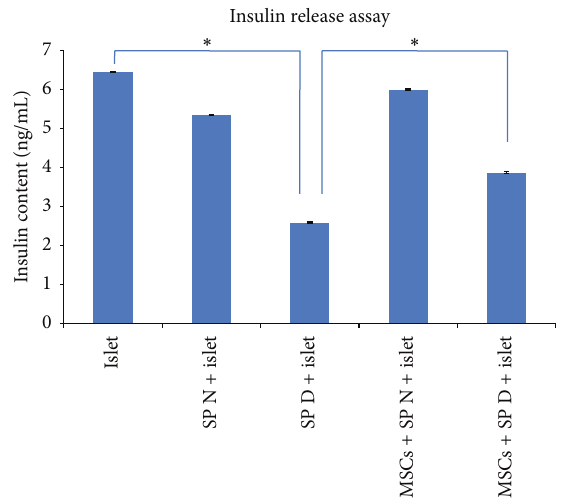
Figure 6: Pancreatic islet insulin release assay. Intact islets alone secreted distinct amount of insulin in response to stimulatory medium (6.45 ± 0.69 ng/mL). However, the insulin secretion lev- els decreased after coculture with diabetic splenocytes (2.59 ± 0.27 ng/mL). Interestingly, addition of AT-MSCs improved insulin secretion by injured islets (3.87 ± 0.41ng/mL). Data presented the mean ± SD of five independent experiments. ∗ indicates significant difference between groups ( 𝑃 < 0.05 ). SP N: normal splenocytes; SP D: diabetic splenocytes; islet: mouse pancreatic